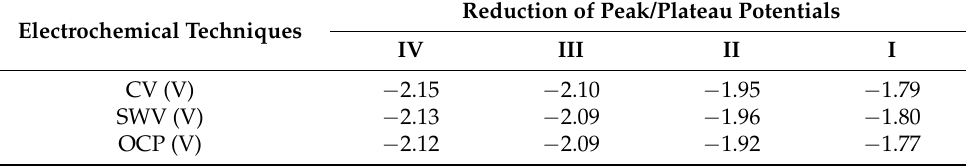
Table 2. Summary of the results obtained on a Pb film electrode through CV, SWV, and OCP in molten LiCl-KCl-YbCl 3 .